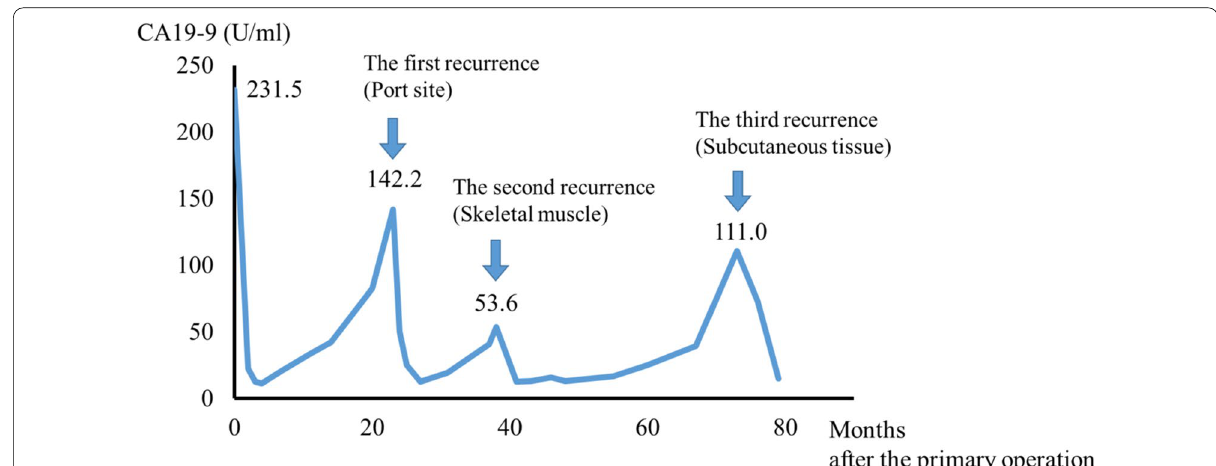
Fig. 1 Serum carbohydrate antigen 19-9 (CA19-9) level after the primary operation. Serum CA19-9 level increased according to each relapse of gastric cancer. It responded to each surgical treatment